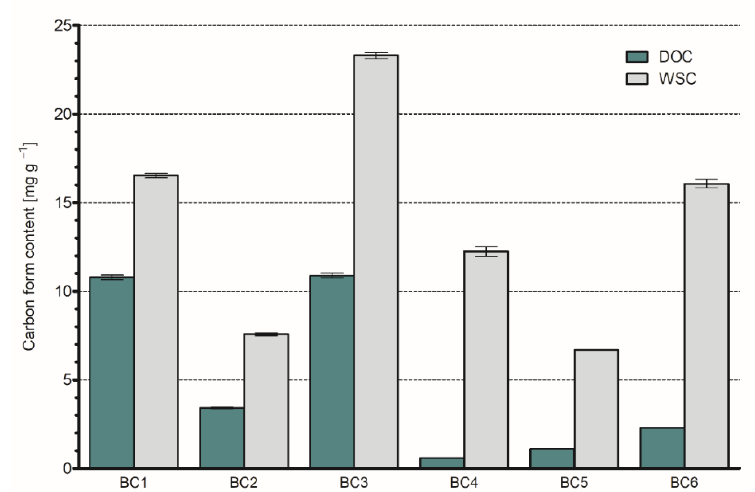
Figure 3. Dissolved organic carbon in water (DOC) and water-soluble carbohydrates (WSC) content in biochars. Values are means with error bars from three